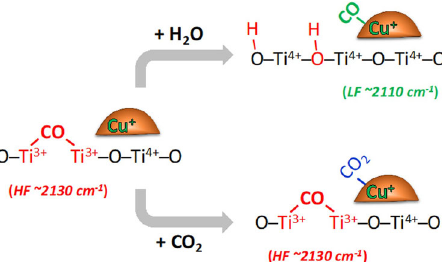
Fig. 6 Schematic of competitive adsorption of CO with H 2 O and CO 2 . H 2 O competes with CO on oxygen vacancies while CO 2 adsorbs on copper